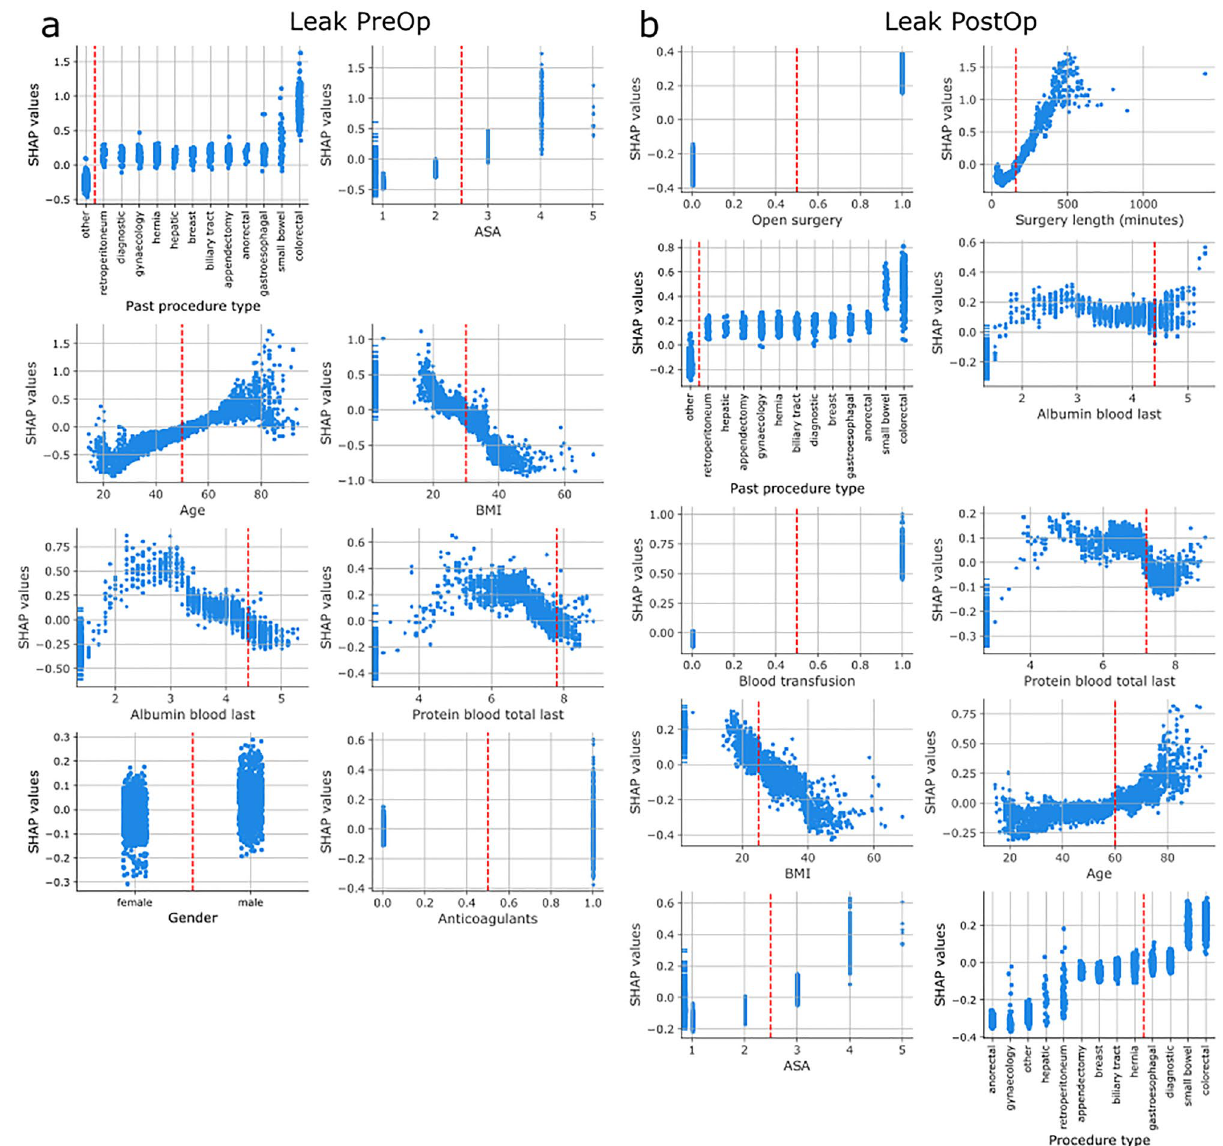
Figure 3. Impact of features of pre- and postoperative leaks risk predictions Subplots show how a given feature affects the risk prediction of the model. X-axes depict the values of the feature, y-axes the associated SHAP values. Missing values are represented on the far left of the x-axis. A positive SHAP value indicates that the value of the feature increases the overall risk, a negative SHAP values lowers risk of postoperative leaks. The larger the magnitude of the SHAP value the more it affects the risk prediction. Red vertical lines indicate inflection points were the value of the feature switches from having a negative to positive (or vice versa) impact on the risk prediction. The arrangement of the subplots follows the order of importance of the features for the model predictions. ( a ) Preoperative leak risk models. Red vertical lines depict: Age = 50 years, BMI = 30 kg / m2, Albumin blood = 4.4 g/dL, Protein blood total: 7.8 g/dL ( b ) Postoperative SSI risk models. Red vertical lines depict: Surgery length = 160 min, Albumin blood = 4.4 g/dL, Protein blood total = 7.2 g/dL, BMI = 25 kg / m2, Age = 60